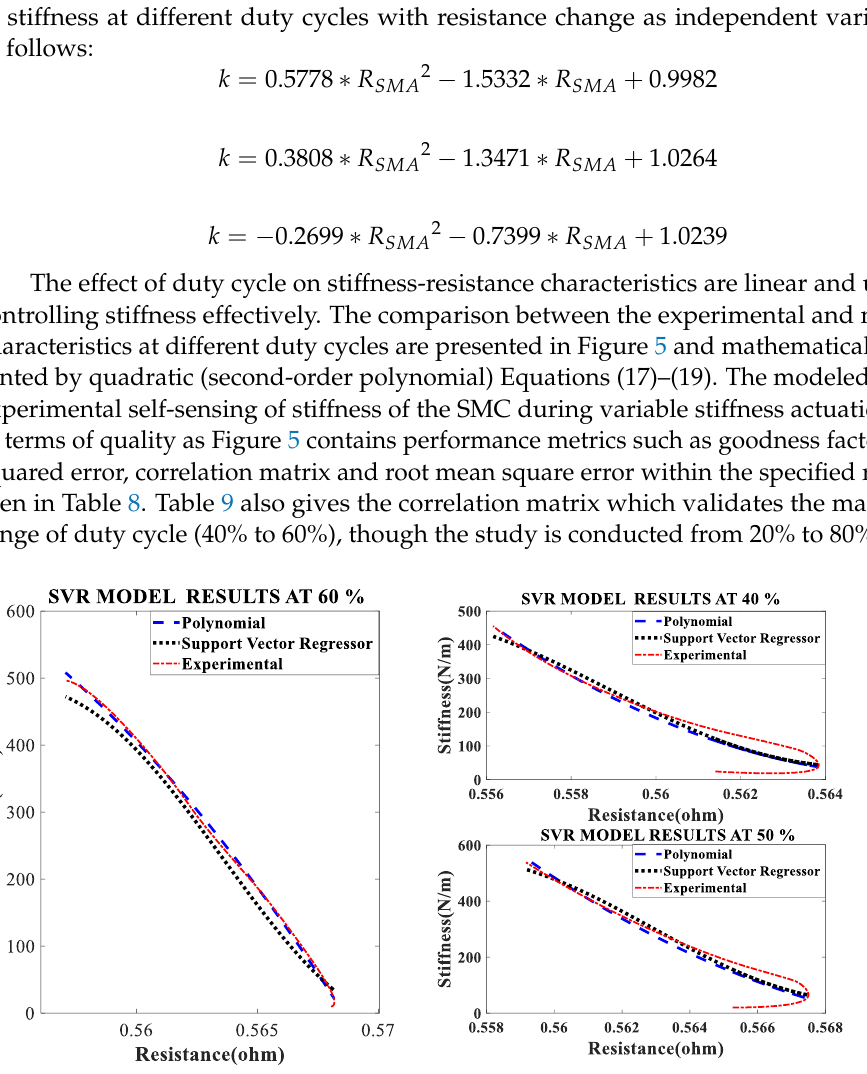
Figure 5. Comparison of models of self-sensing stiffness characteristics with experimental results at different duty cycles. Table 8. Metrics of Inferential models at different duty cycles.